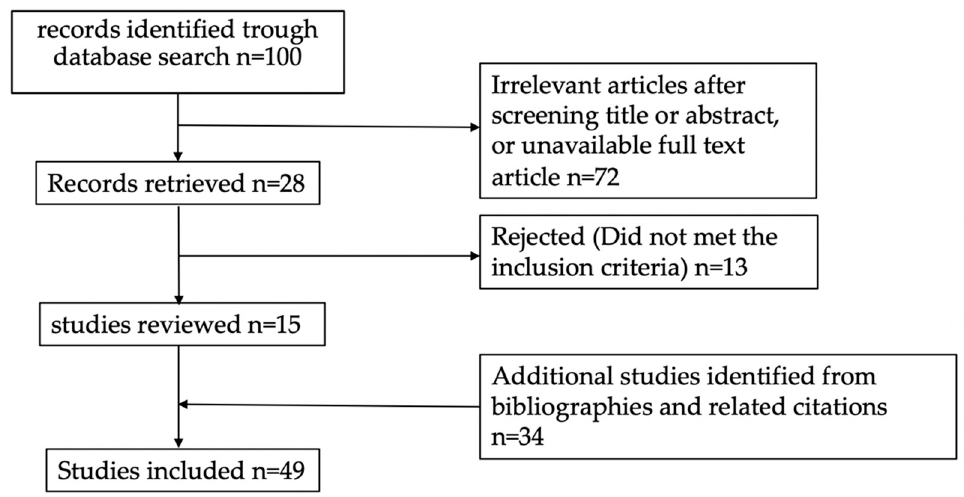
Figure 2. Flow chart illustrating the screening and selection process.